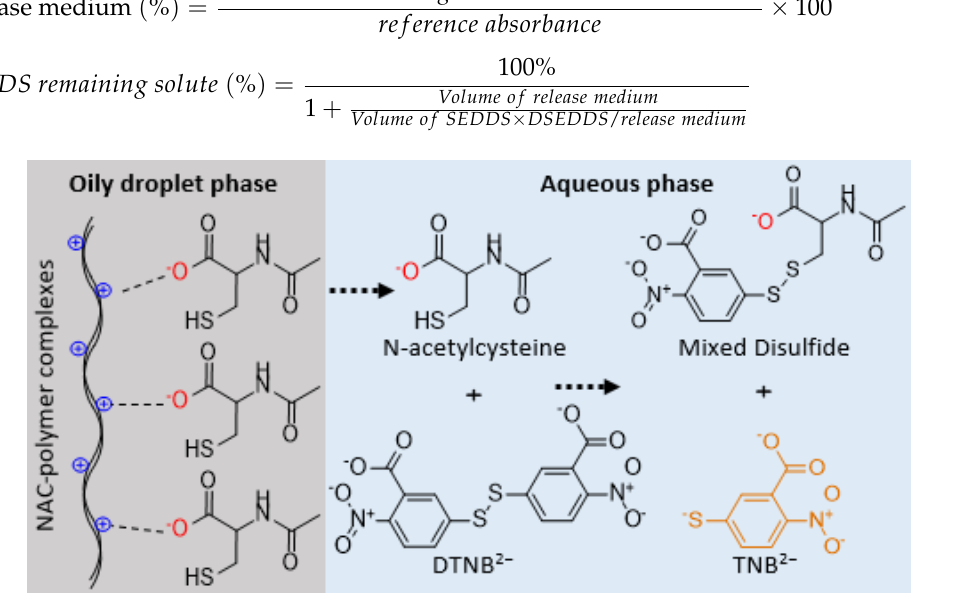
Figure 2. A diagram depicting the quantification approach of the released N -acetylcysteine from SEDDS oily droplets. TNB 2 − , 2-nitro-5-thiobenzoate dianion; DTNB 2 − , 5,5′ -dithiobis(2-nitrobenzoic acid) dianion.